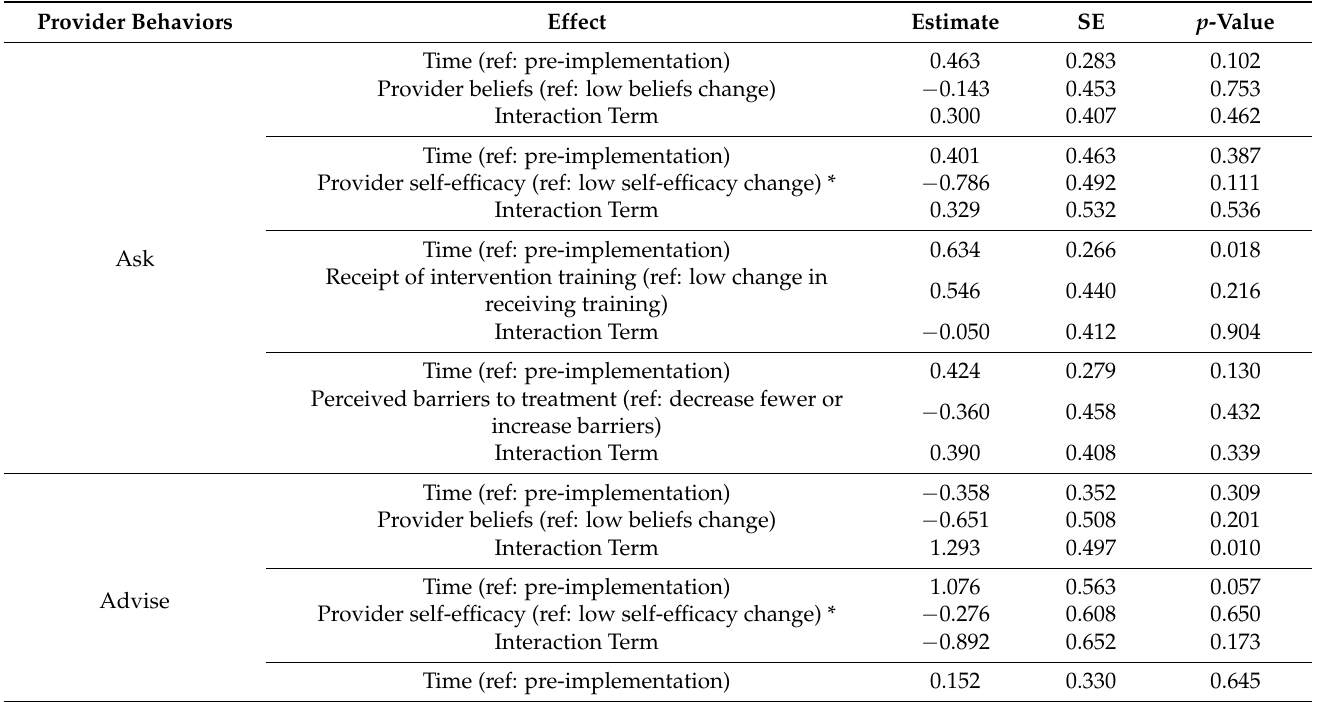
Table 4. Center-level Changes as Moderators of Providers’ Delivery of the 5A’s for Non-cigarette Tobacco Use from Pre- to Post-Implementation of a Comprehensive Tobacco-Free Workplace Program (N = 15